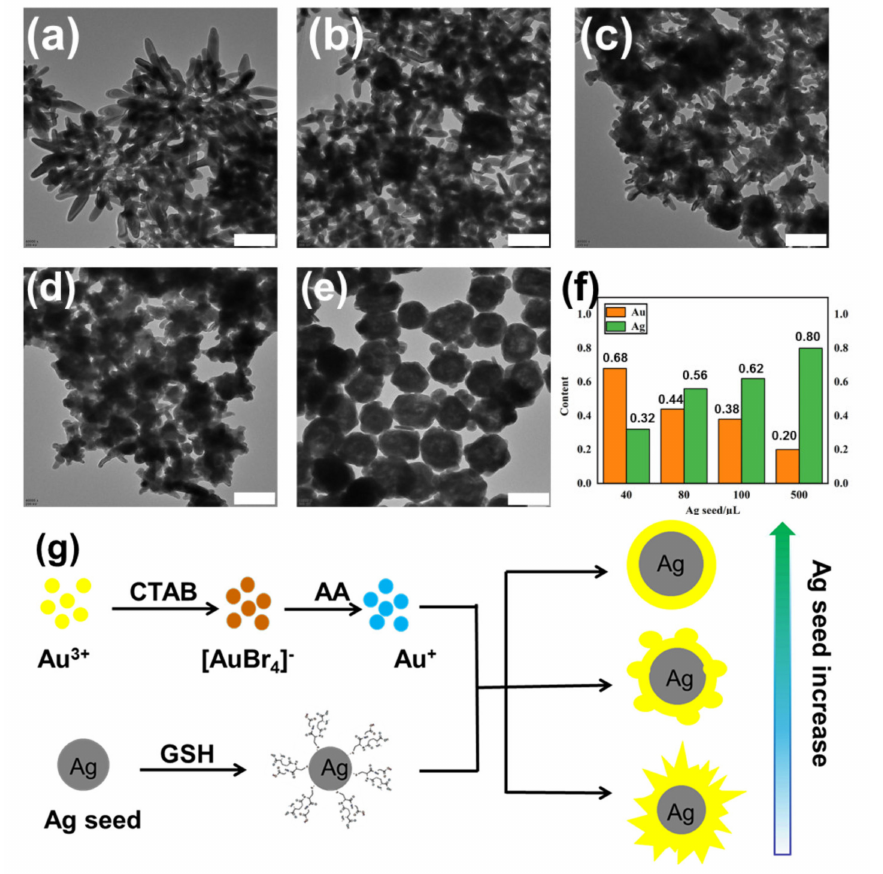
Figure 3. TEM images of as-prepared Ag@Au nanoparticles, when the amount of Ag seed added was ( a ) 0 µ L, ( b ) 40 µ L, ( c ) 80 µ L, ( d ) 160 µ L, and ( e ) 500 µ L. ( f ) A statistical graph of the atomic ratio of Ag and Au in Ag@Au nanoparticles prepared with different amounts of silver seeds, according to the EDS results. ( g ) Schematic diagram of the growth process of Ag@Au nanoparticles. Scale bar: 100